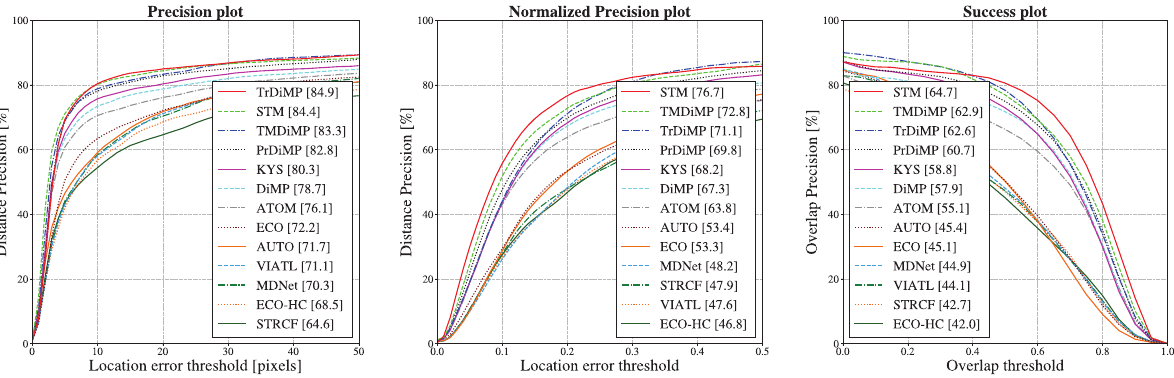
Figure 9. Precision, normalized precision, and success plots of OPE on UAVDT.